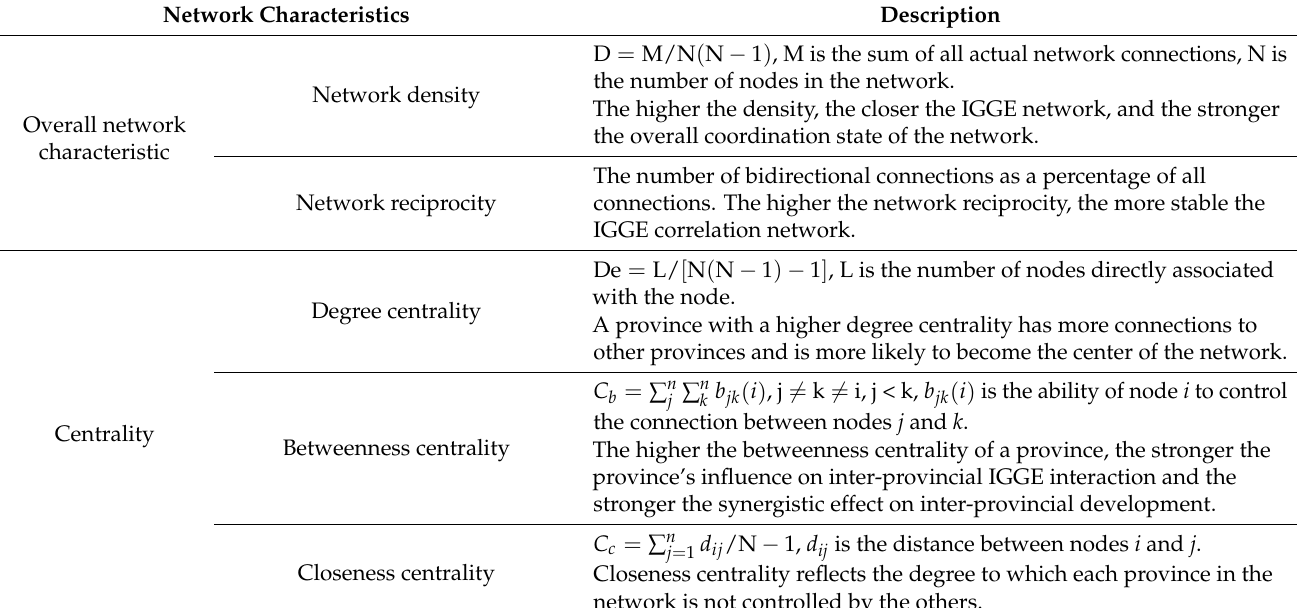
Table 2. Calculation methods of the social network characteristics.